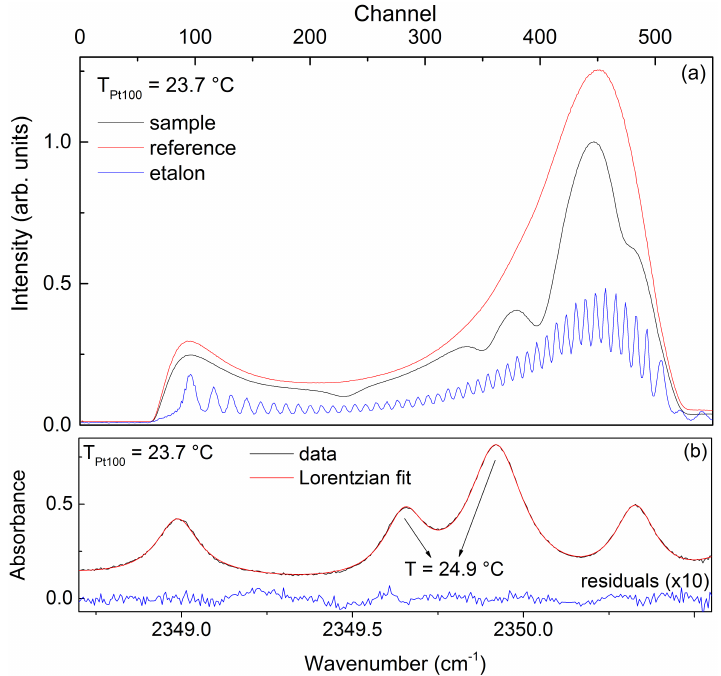
Figure 4. ( a ) Example intensity spectra obtained for CO 2 -enriched air (black), N 2 as reference gas (red), and a solid germanium etalon (blue) with an averaging time of 25 s (1500 scans). The temperature as determined by the Pt100 sensor was 23.7 ◦ C; ( b ) corresponding absorbance spectrum (black) derived from Beer–Lamberts law and frequency calibration by the etalon transmission pattern. The red and blue line represents best-fit data and residuals, respectively, applying a Lorentzian curve model (see text for further details). Laser repetition rate: 50 kHz, current ramp duration: 10 ms, τ s = 16.7 ms, p = 1010